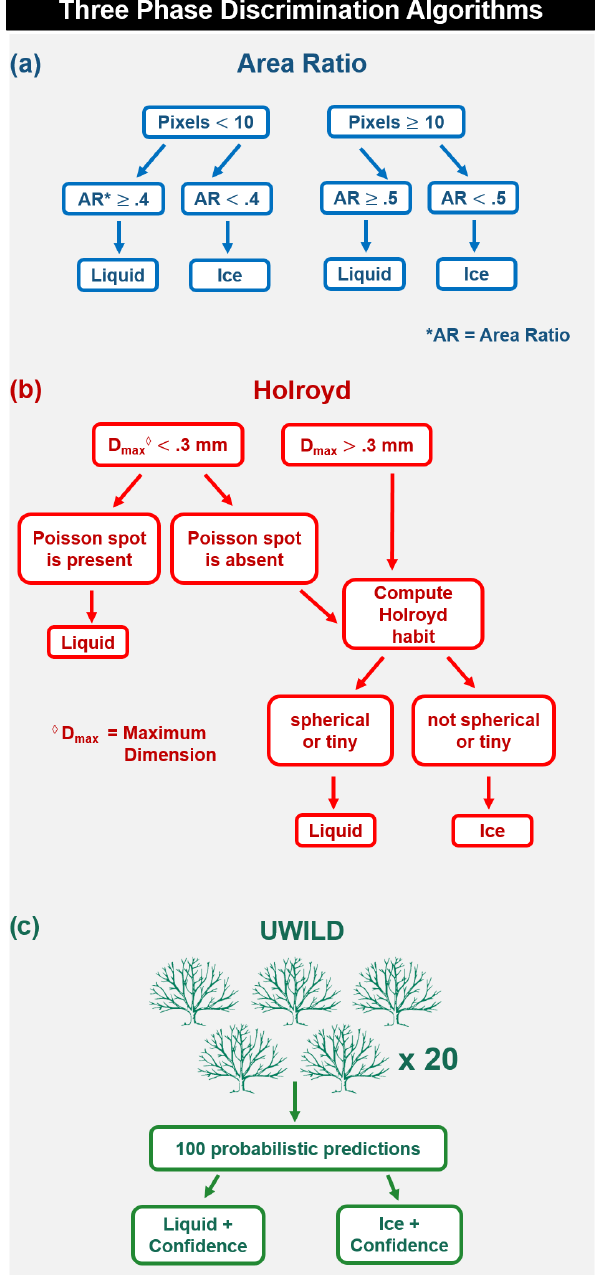
Figure 1. Schematic comparing the three-phase classification al- gorithms compared in this study. Using single-particle properties derived from the 2D-S probe as input, each panel describes the al- gorithm decision tree used to classify a particle as liquid or ice.